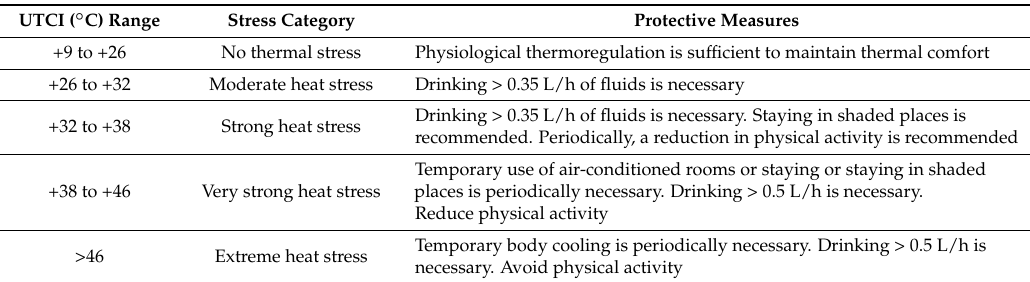
Table 2. UTCI range and corresponding thermal stress level.